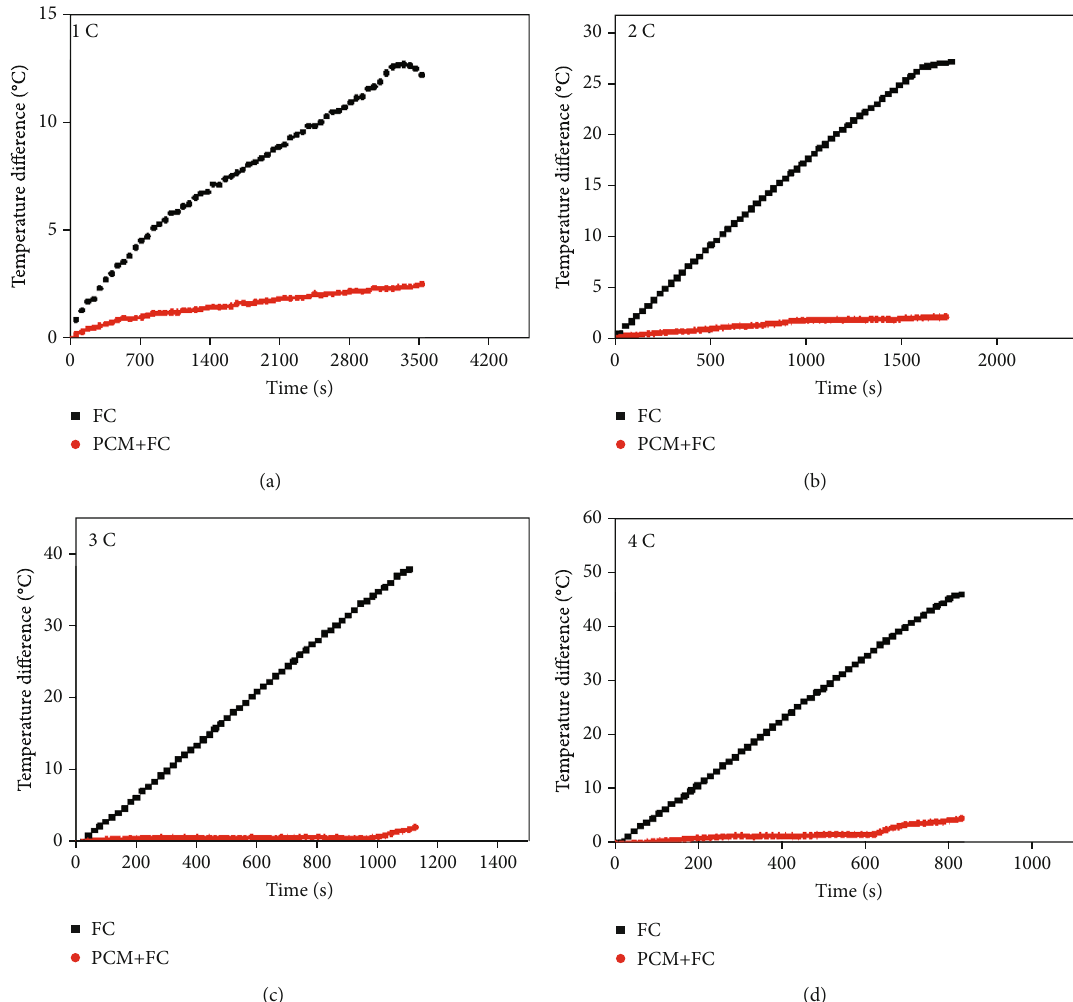
Figure 11: Temperature consistency comparison of the battery modules with di ff erent cooling media (3